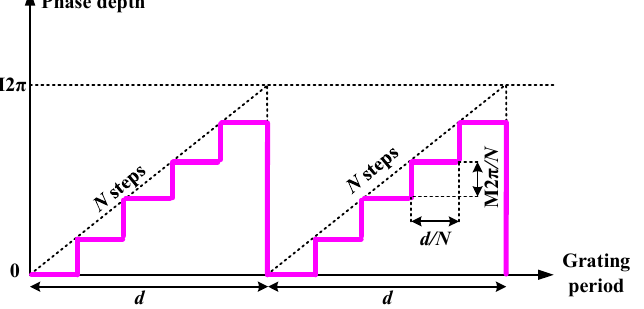
Figure 5. The partial phase profile of the hologram with three different grey levels displayed on the active area of an LCOS SLM: a target image ( a ), the corresponding CGH hologram ( b ), a selected area of the hologram ( c ), and the grey levels ( d ).